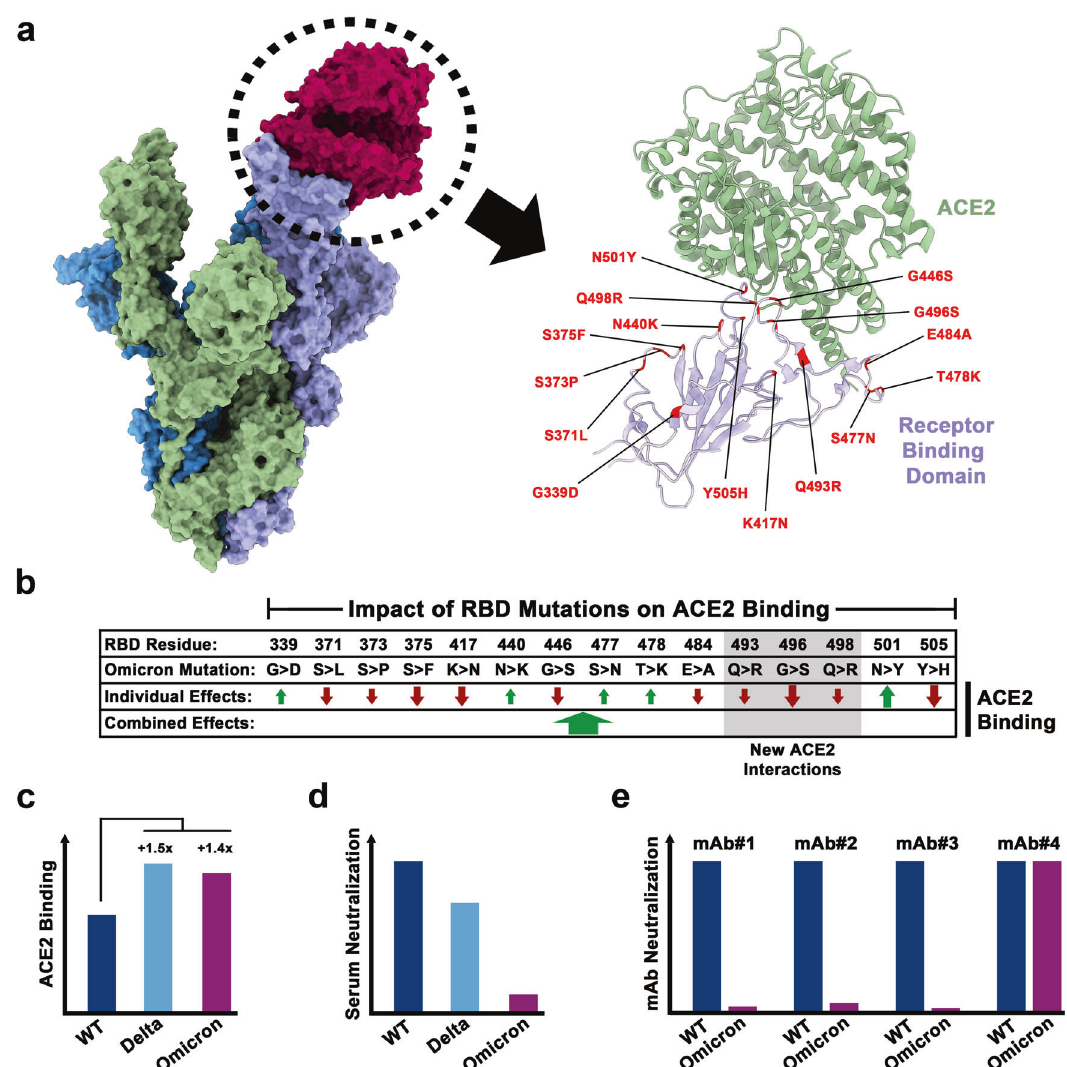
Fig. 1 ACE2 interactions and resistance against antibody-mediated neutralization of the Omicron spike protein. a Left panel: Model of the trimeric SARS-CoV-2 spike protein bound to ACE2 (red). Right panel: Close-up on the binding interface of the receptor binding domain (RBD) of the SARS-CoV-2 spike protein (violet) and ACE2 (green). RBD residues that are mutated in the Omicron variant sublineage (BA.1) are highlighted (red). b Individual and combined impact of Omicron-speci fi c RBD mutations. Omicron residues that establish new interactions with ACE2 are highlighted (gray). c Relative ACE2 binding by the spike proteins of wild-type (WT) SARS-CoV-2 and SARS-CoV-2 variants Delta and Omicron. d Convalescent and vaccinee sera exhibit low neutralization potency against the Omicron variant. e The Omicron variant is resistant against most monoclonal antibodies (mAbs) that neutralize WT SARS-CoV-2 with high